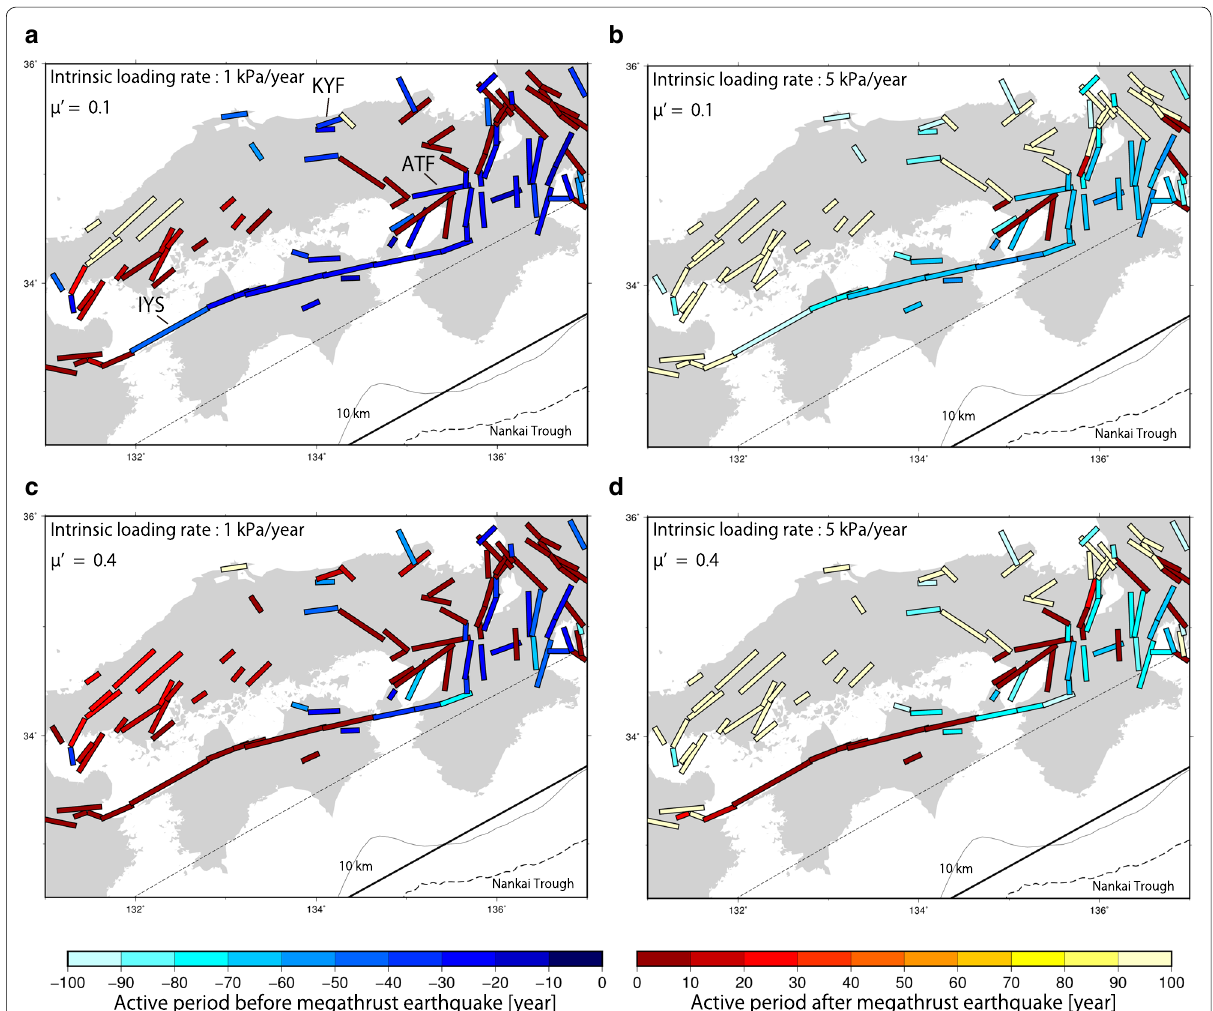
Fig. 5 Active period of the major active faults in southwest Japan. The major active fault parameters are derived from Earthquake Research Committee (2018). The colored areas represent the active periods of the inland faults before or after the megathrust earthquakes. The black solid and dashed lines indicate the upper and lower edges of the rectangular megathrust fault, respectively. The active period is calculated by varying the intrinsic loading rate ( �τ intrinsic